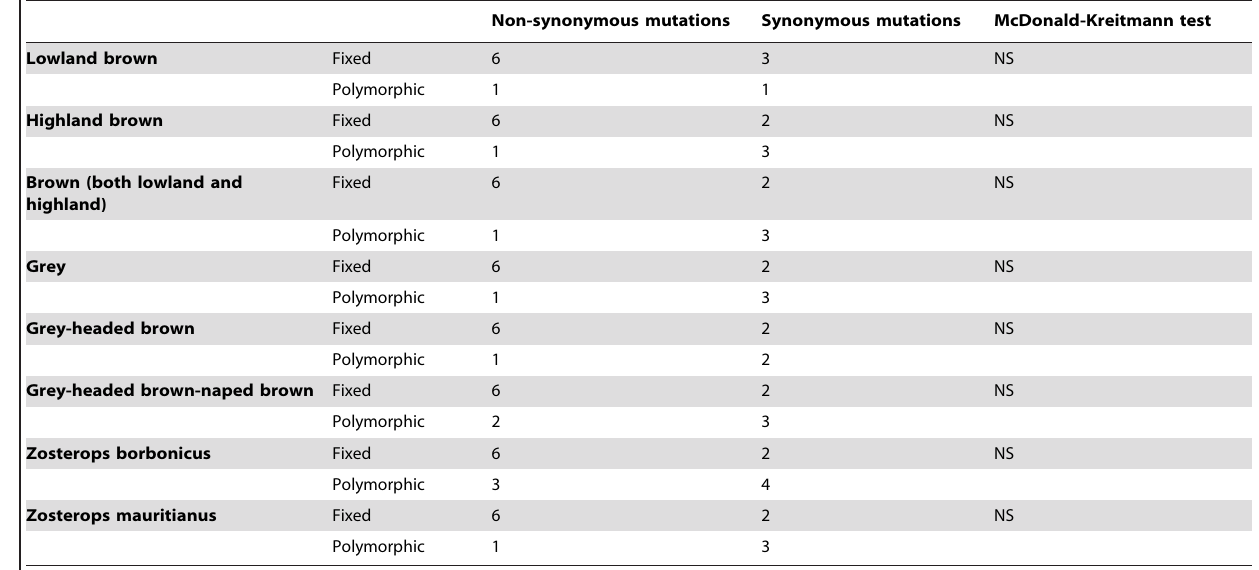
Table 4. Results for McDonald-Kreitman neutrality test.